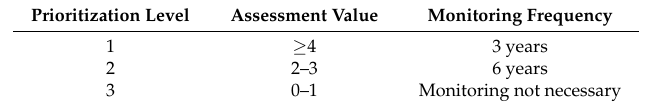
Table 4. Prioritisation level and monitoring frequency depending on the assessment value.